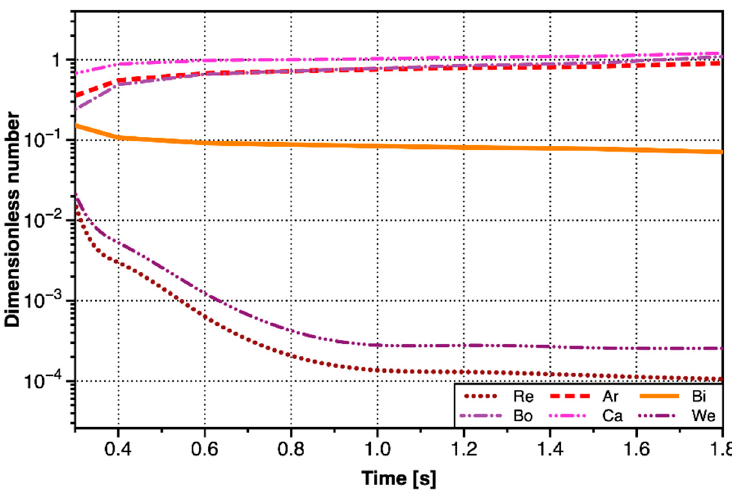
Figure 11. The curves of the dimensionless number of the minor bubble with time.